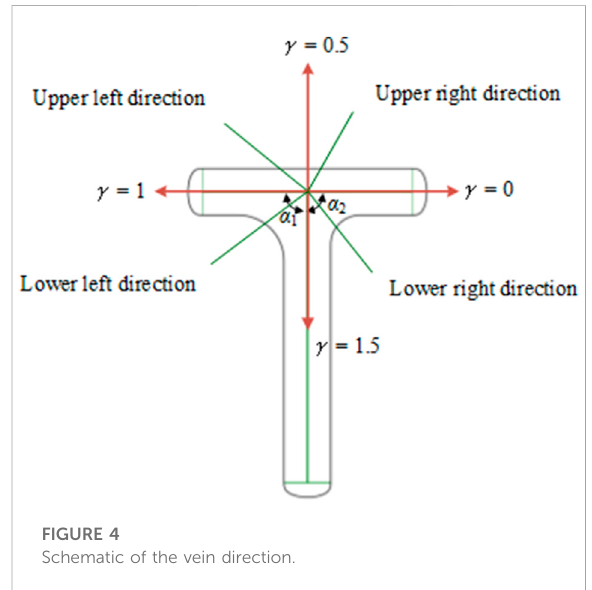
FIGURE 4 Schematic of the vein direction.